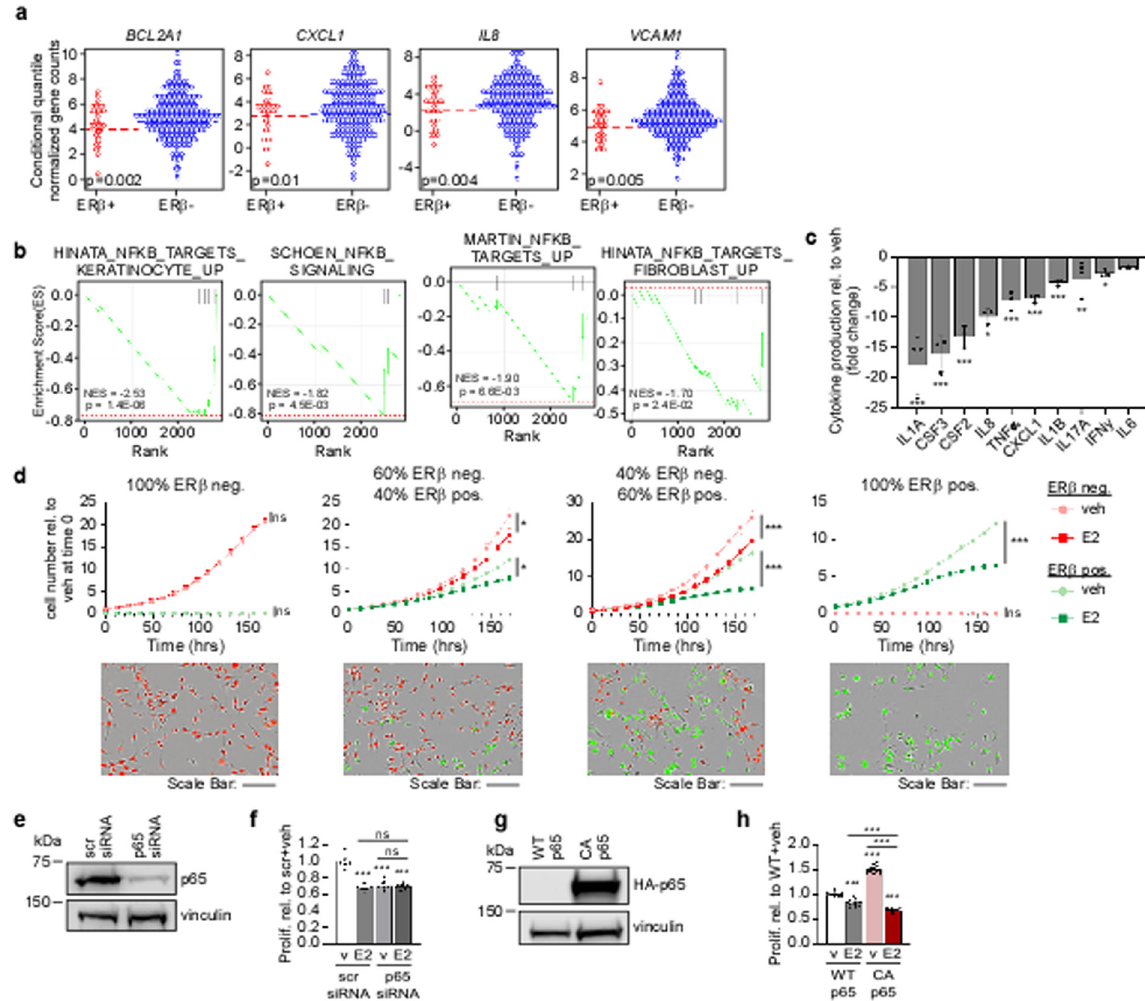
Fig. 2 Relevance of NF κ B/p65 pathway to ER β ’ s tumor suppressive properties. a Expression of NF κ B/p65 target genes shown to be suppressed by ER β in TNBC cell lines in ER β + ( n = 32) versus ER β − ( n = 225) TN breast tumors from the Mayo Clinic Cohort as assessed by RNA-seq. Dashed line indicates median expression. b GSEA of differentially expressed genes in ER β + tumors versus ER β − tumors revealed negative correlations with NF κ B/p65 pathways. c Protein levels of NF κ B/p65 target genes in conditioned medium isolated from MDA-MB-231- ER β cells treated with E2 + dox for fi ve days relative to vehicle + dox as determined via a cytokine array. d Co-culture real-time proliferation assays of parental (red) and ER β -expressing (green) MDA-MB-231 cells treated with veh + dox or E2 + dox using an IncuCyte S3 system. Representative images of wells are shown in bottom panels. Scale bars are equivalent to 200 µm. e Western blot indicating knockdown of p65 protein following transfection of p65-speci fi c siRNAs relative to scramble control (scr). f Proliferation rates of dox treated MDA-MB-231-ER β data is presented as mean ± SEM. ( c , f , h ), * P < 0.05, ** P < 0.01, *** P < 0.001 relative to vehicle (one-way ANOVA). ( d ) * P < 0.05, ** P < 0.01, *** P < 0.001 as determined via two-way